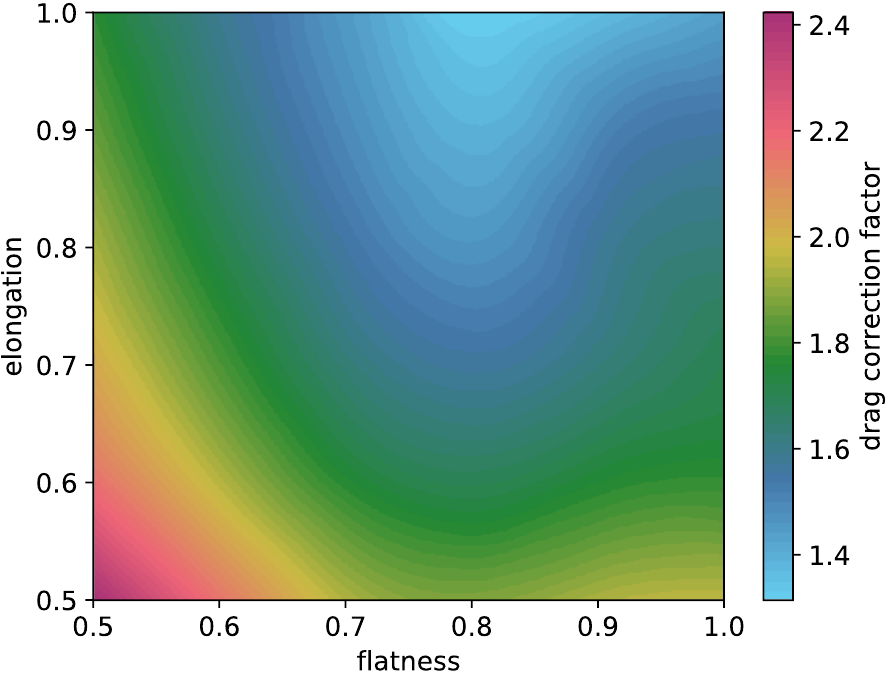
Figure 8. Dependency of the drag correction factor on elongation and